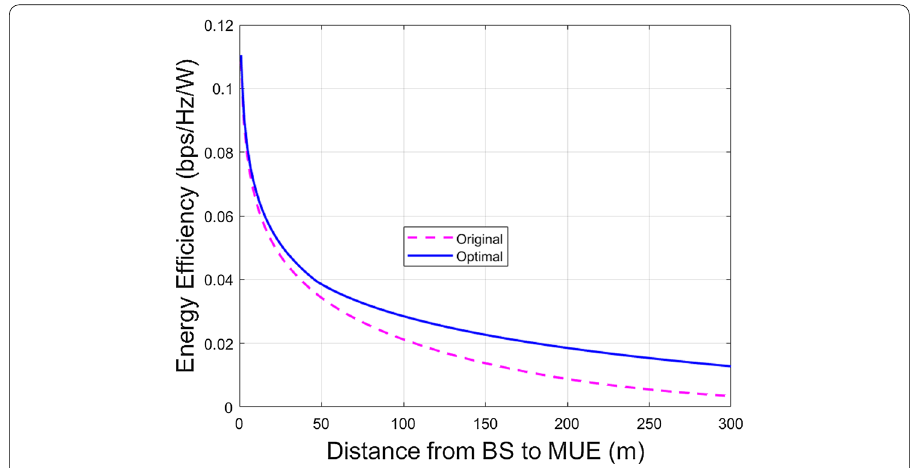
Fig. 10 Energy efficiency vs. distance from BS to MUE comparison in